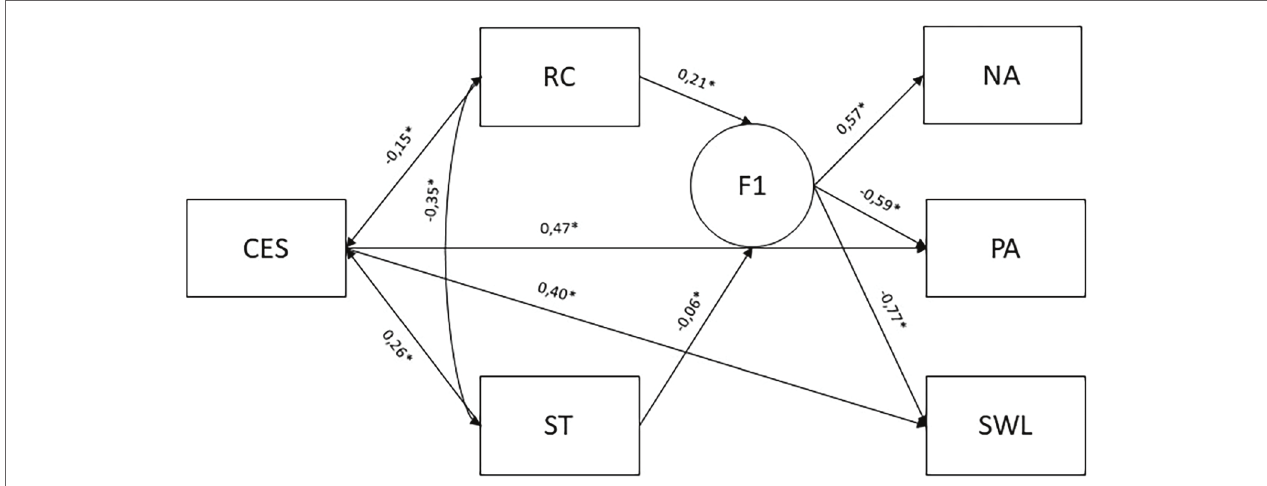
FIGURE 1 | Structural model of Spiritual Transcendence, Religious Crisis, and Centrality of Event predicting Subjective Well-Being, with standardized estimates. NA, Negative Affect; PA, Positive Affect; SWL, Satisfaction with Life; CES, Centrality Event Scale; ST, Spiritual Transcendence; RC, Religious